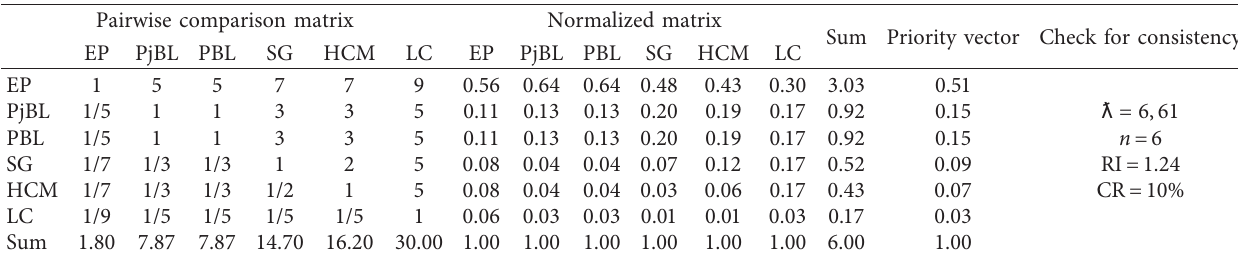
Table 13: Pairwise comparison matrix of learning strategies with respect to the Criterion “SS5. Professional responsibility.” Pairwise comparison matrix